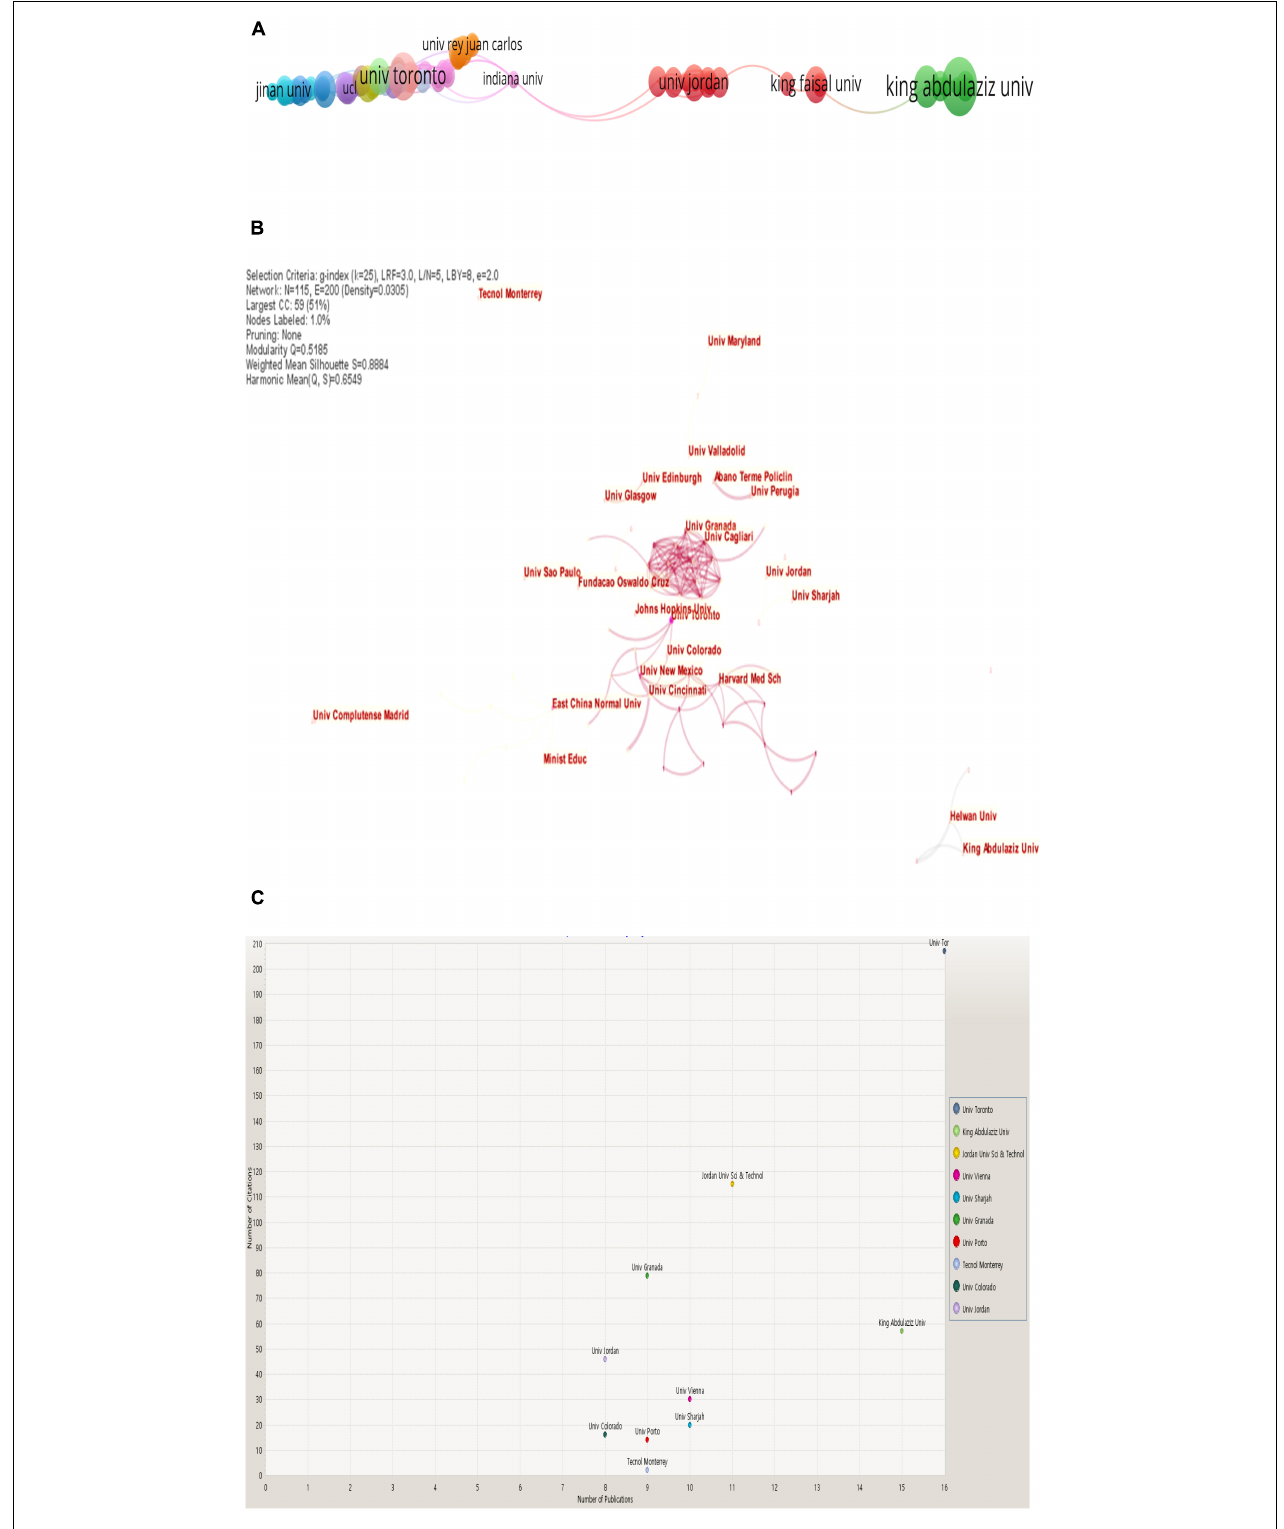
FIGURE 4 | (A) Network of organizations (VOSviewer outputs). (B) Network of organizations (CiteSpace outputs). (C) Citations per publications by the organization (KnowledgeMatrix Plus outputs).